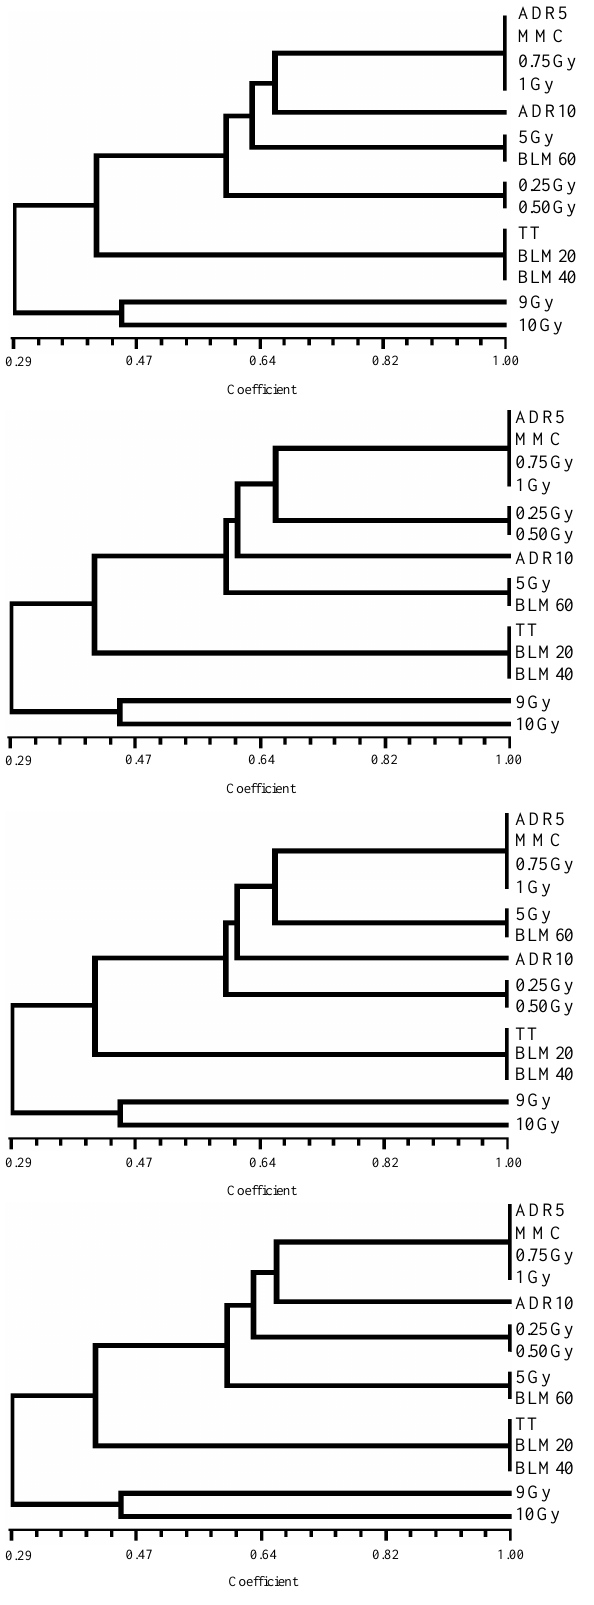
Figure 2 - Consensus dendrogram (majority rule) obtained from the four phenograms presented in Figure 1. The CCC was 0.58333. See references on Material and Methods, and Table